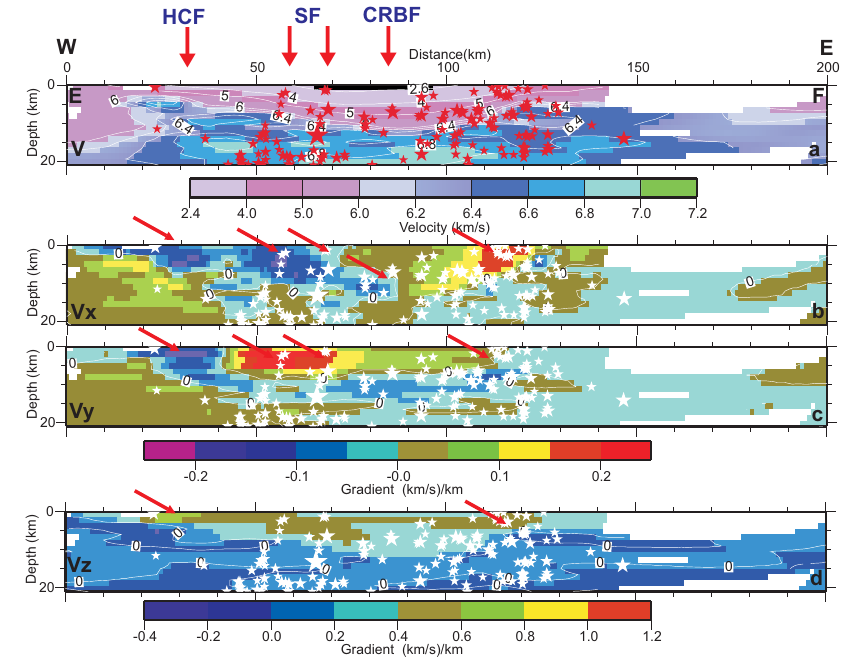
Fig. 4. Profile EF. Vertical cross-section of (a) tomographic velocity model (b) X gradient of velocity model, (c) Y gradient of velocity model, and (d) Z gradient of velocity model. Abbreviations as in Fig.